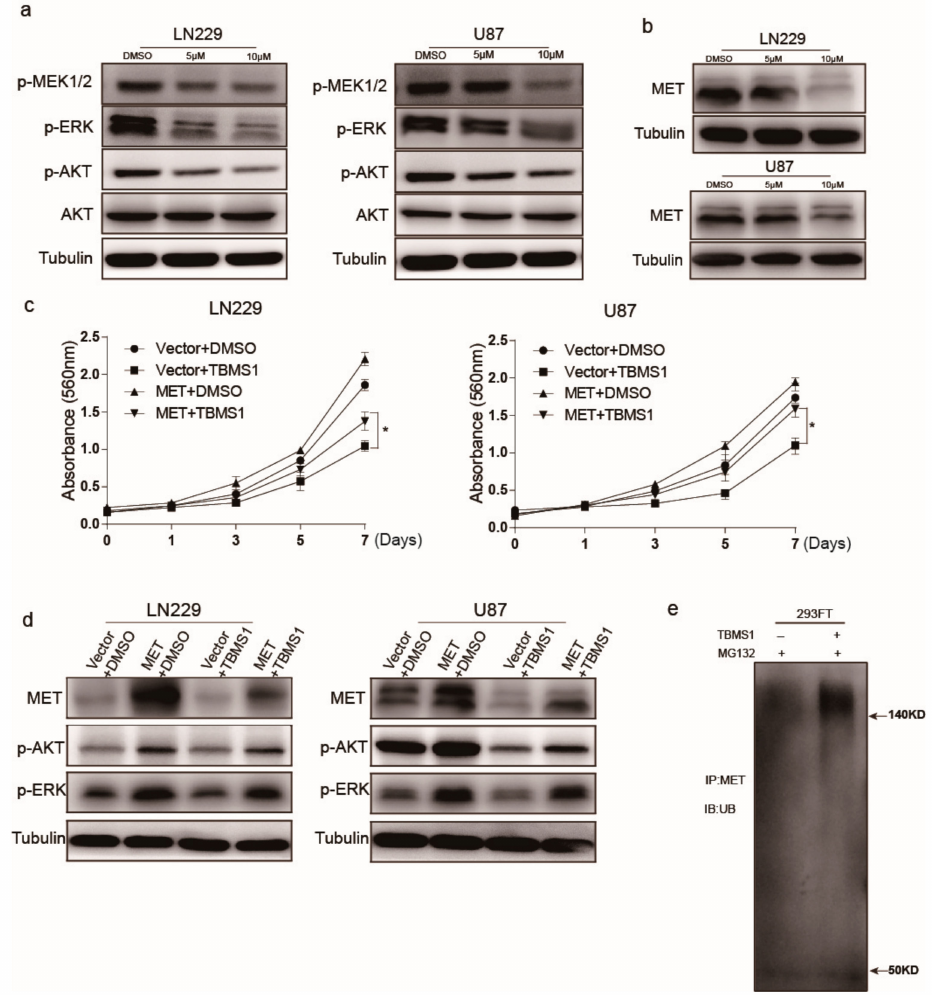
Figure 4. TBMS1 inhibits glioblastoma cells activation of AKT, ERK pathway by enhancing MET ubiquitination degradation. ( a ) The expression levels of p-MEK, p-ERK, p-AKT, AKT, and Tubulin proteins in LN229 and U87 cells were measured by western blot treated with di ff erent concentrations of TBMS1. DMSO was added as a control. ( b ) The expression levels of MET and Tubulin proteins in LN229 and U87 cells were measured by western blot treated with di ff erent concentrations of TBMS1. DMSO was added as a control. ( c ) Viability of LN229 and U87 cells overexpressing MET and